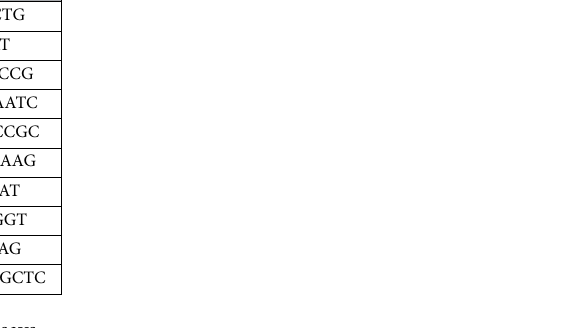
Table 1. Primers used for real-time PCR